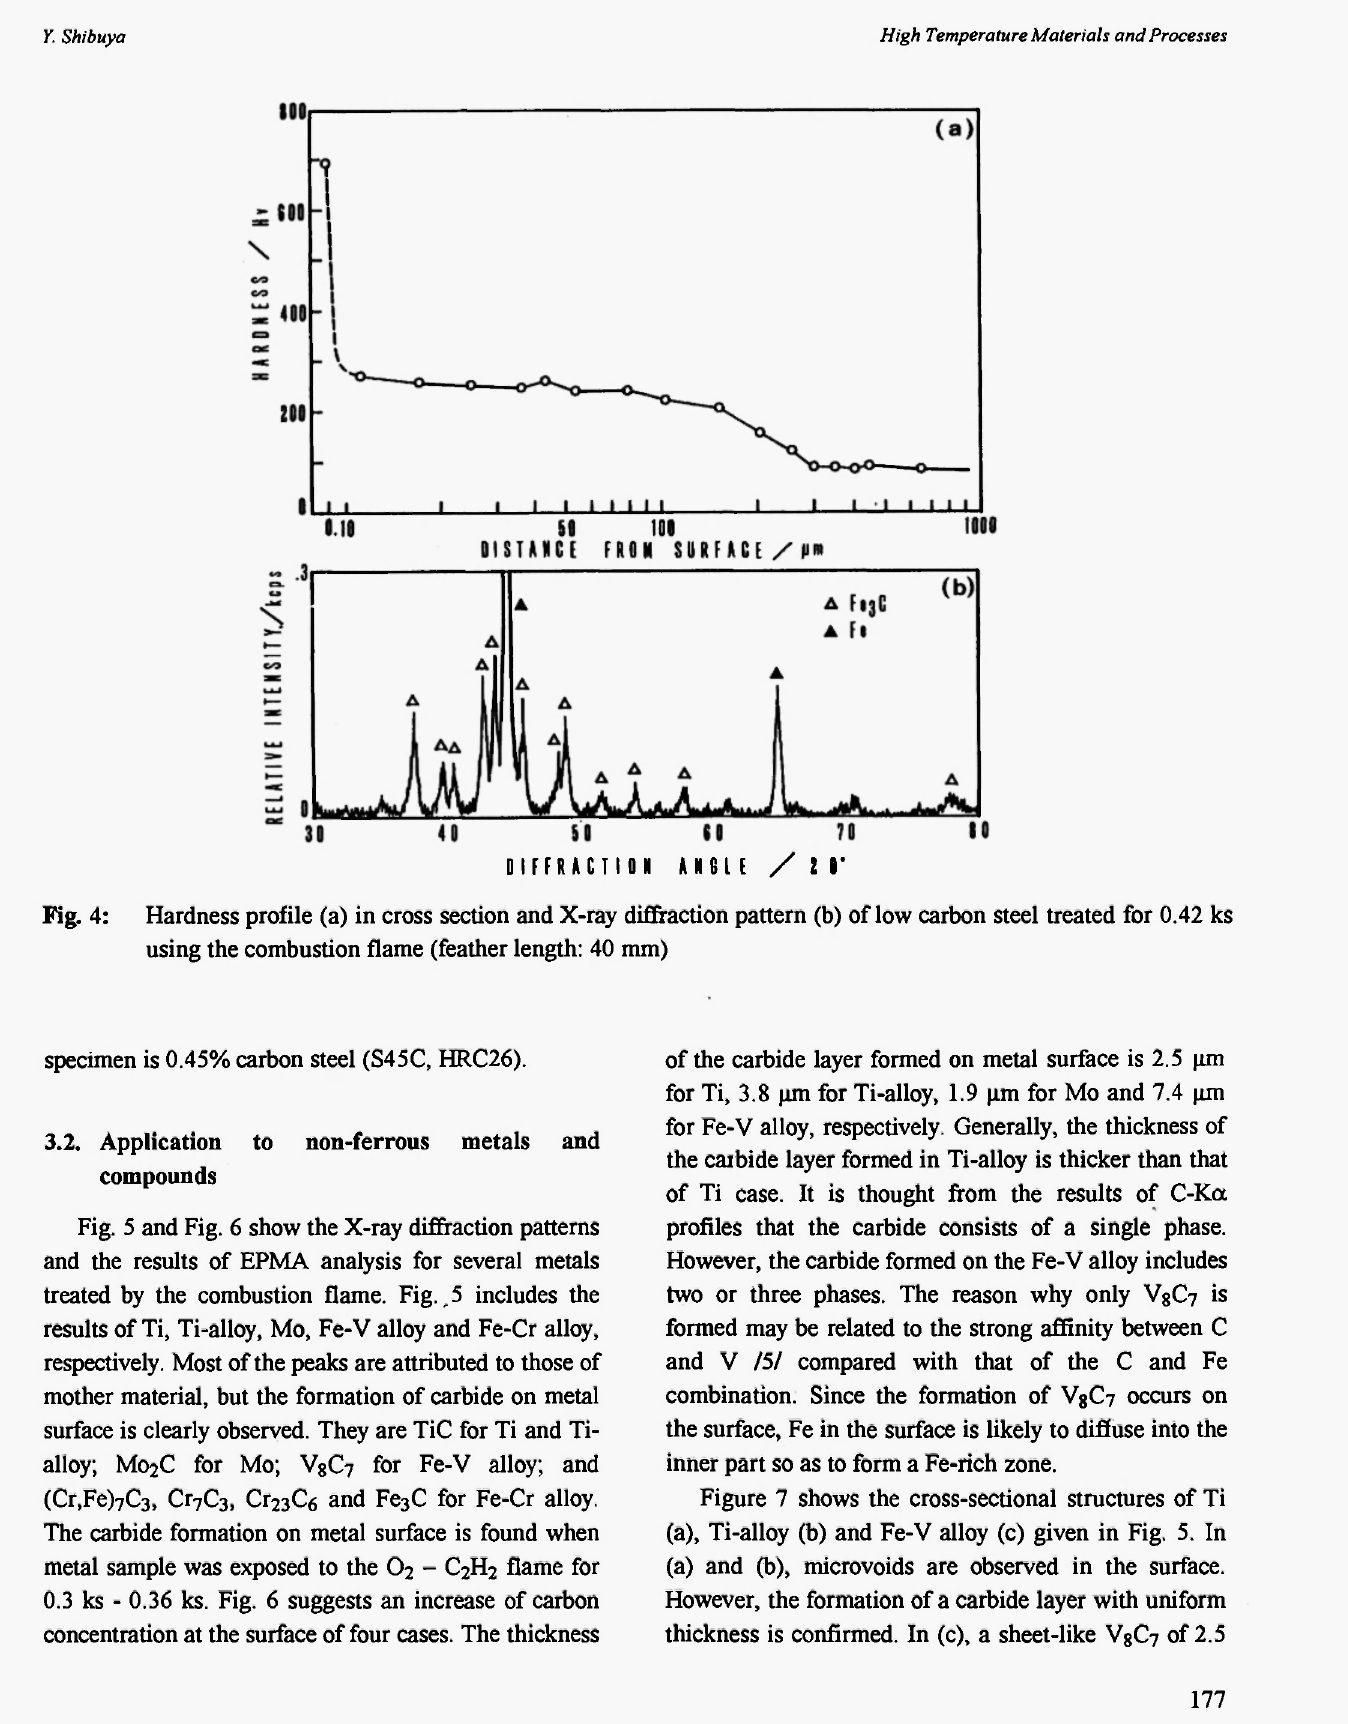
DIFFRACTION ANGLE / \V Fig. 4: Hardness profile (a) in cross section and X-ray diffraction pattern (b) of low carbon steel treated for 0.42 ks using the combustion flame (feather length: 40 mm)